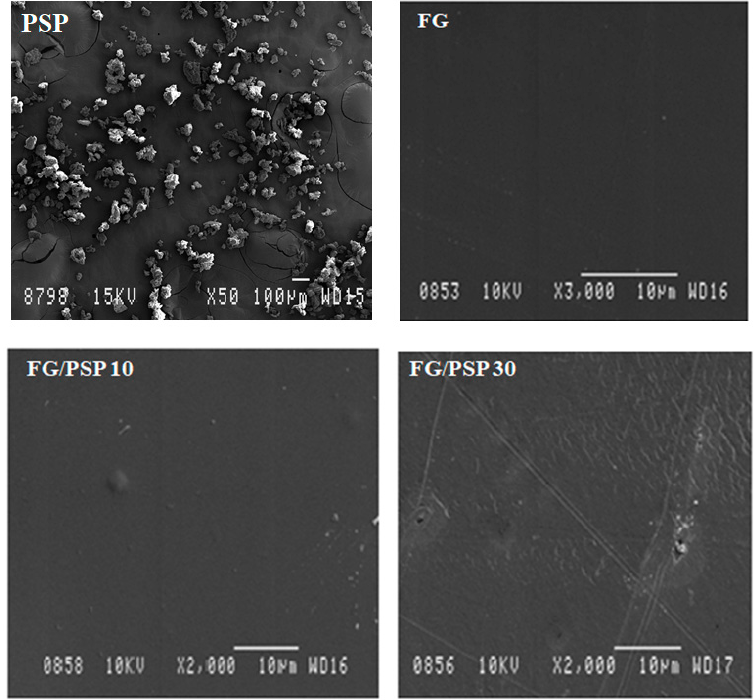
Figure 1. SEM micrographs of the surface of PSP and fish gelatin films containing PSP.